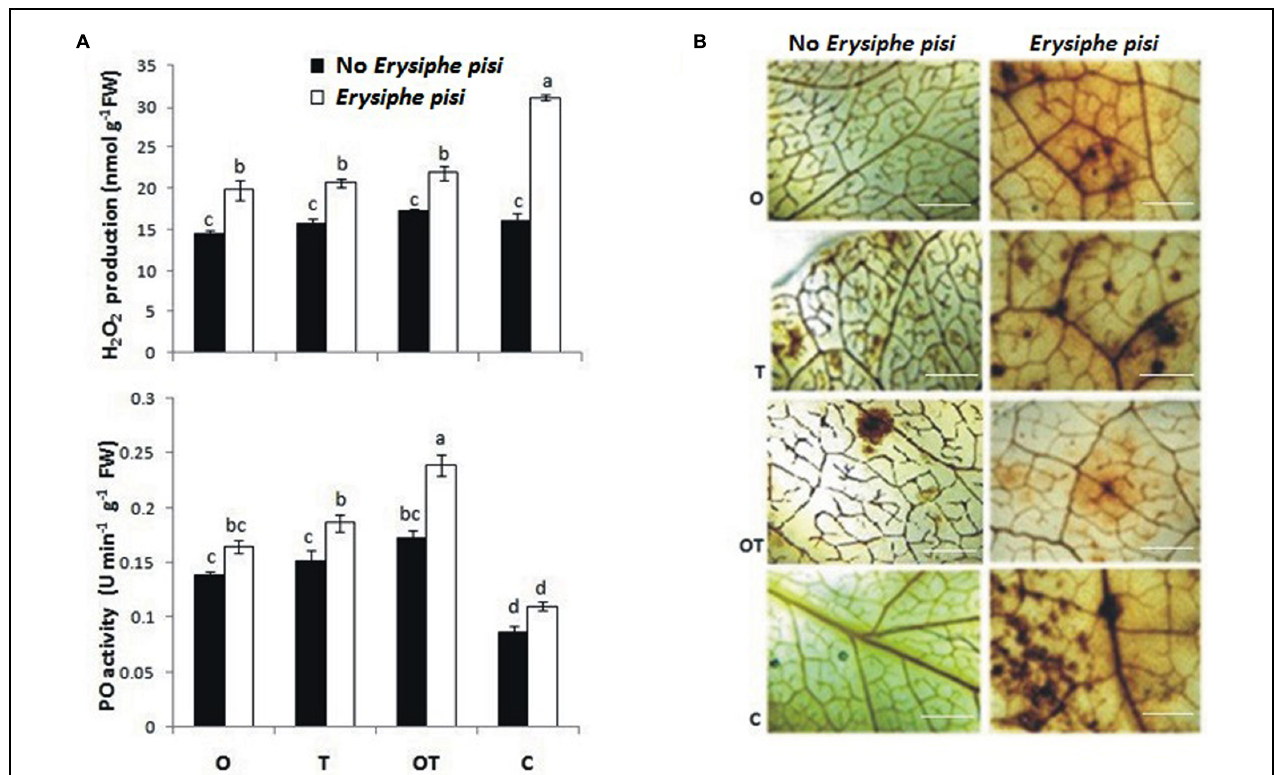
FIGURE 4 | Reactive oxygen species [hydrogen peroxide (H 2 O 2 )] generation and antioxidant [peroxidase (PO)] activities in pea leaves modulated by P. fluorescens OKC and T. asperellum T42 during challenge by the biotroph fungal pathogen E. pisi as analyzed through spectrophotometrically and histochemical staining. (A) H 2 O 2 accumulation and PO activities in pea leaves raised from different treatments: O- P. fluorescens OKC, T - T. asperellum T42, OT- combination of OKC and T42, C- Control after 24 h of E. pisi challenge. Error bars represent SD from means of three measurements. Different superscript letters indicate data significantly different from the other treatments ( P ≤ 0.05; Duncan’s multiple range test). (B) Histochemical staining confirms biochemical estimation of